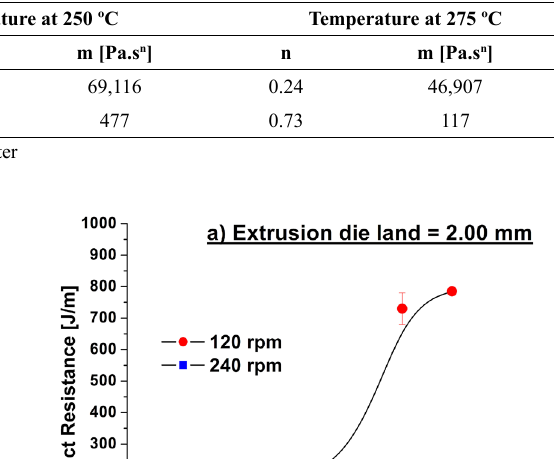
lower in the blends processed at higher speed for extrusion dies with different